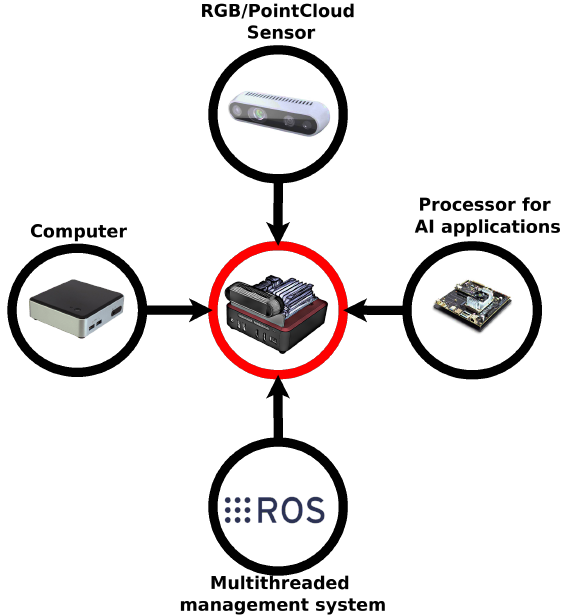
Figure 1. Intelligent 3D Perception (I3P)